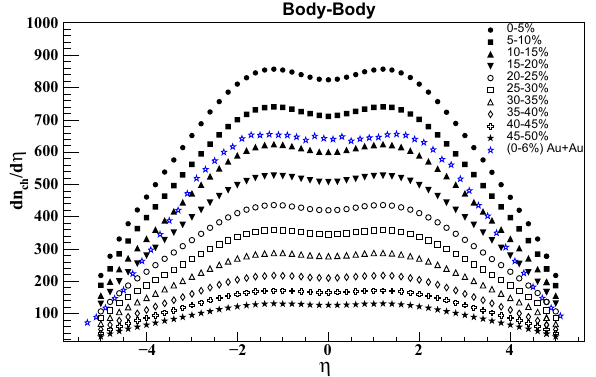
Fig. 10 Variationof dn ch / d η withrespectto η isshownforbody–body configuration of U + U collisions in different centrality class